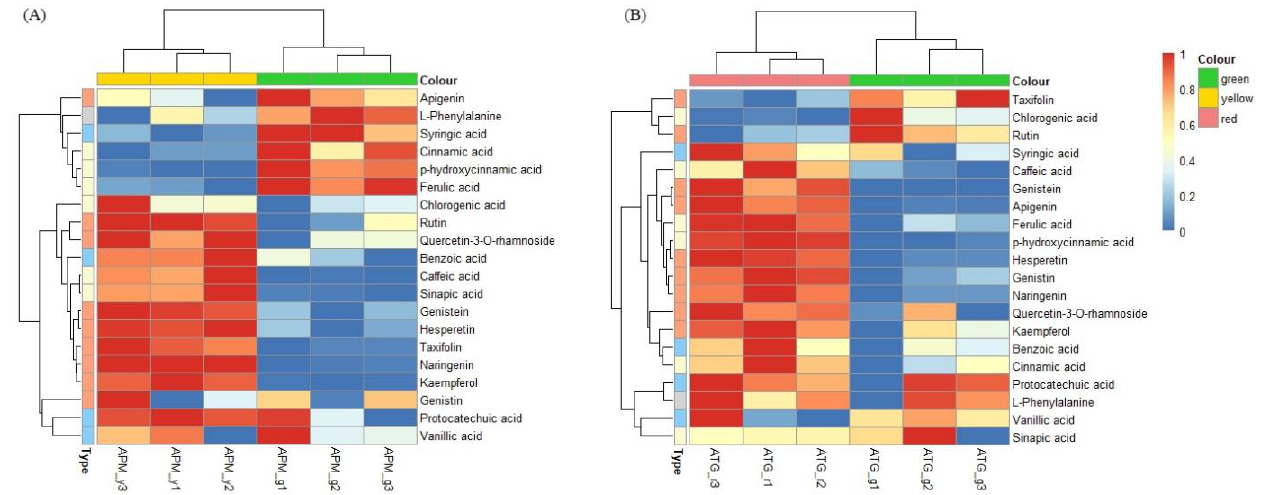
Figure 7. Cluster analysis of phenolic compounds in leaves during different seasons: ( A ) APM and ( B ) ATG. Three biological replicates per group; blue indicates low compound accumulation, while red indicates high compound accumulation.